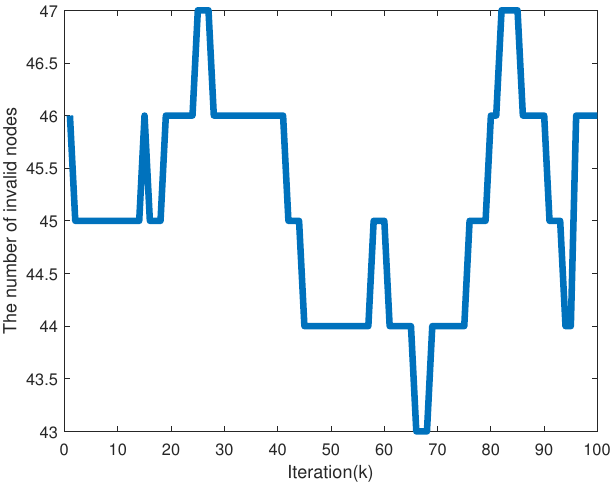
Figure 3. The number of invalid